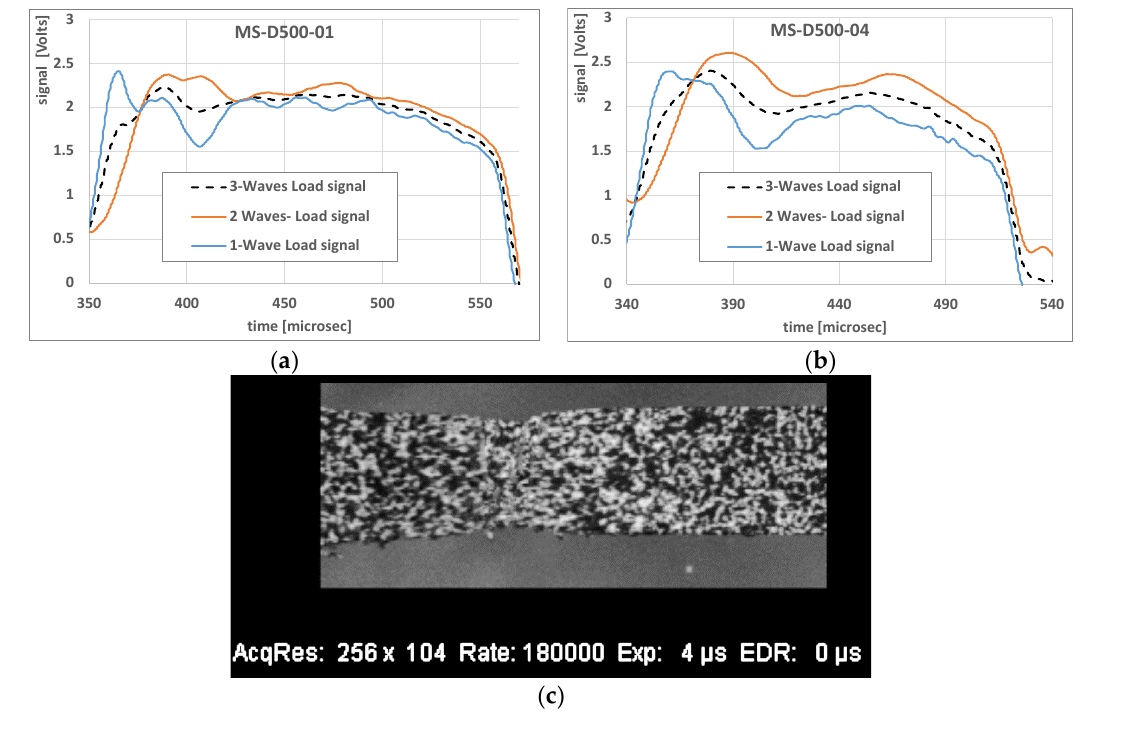
Figure 3. Load histories according to the one-wave, two-wave and three-wave procedures of MS1700-D500-01 ( a ) and 04 ( b ) dynamic SHTB tests. Typical frame at incipient failure from a dynamic test ( c ).